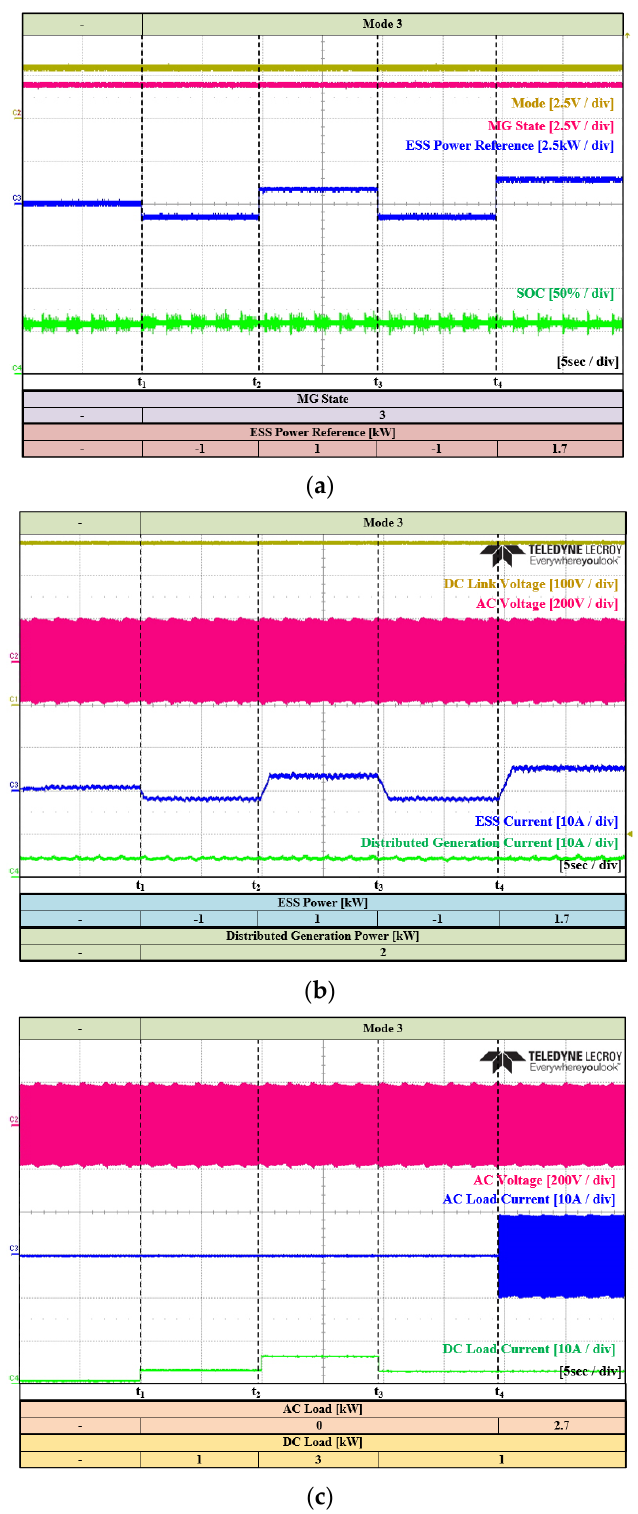
Figure 23. Experimental waveforms of standalone Mode 3. ( a ). Waveforms of the input data (MG state, SOC) and output data (Mode, ESS power reference) of the ANN. ( b ) Waveforms of DC link and AC voltage, ESS, and DG current. ( c ) Waveforms of each load current and AC grid voltage.